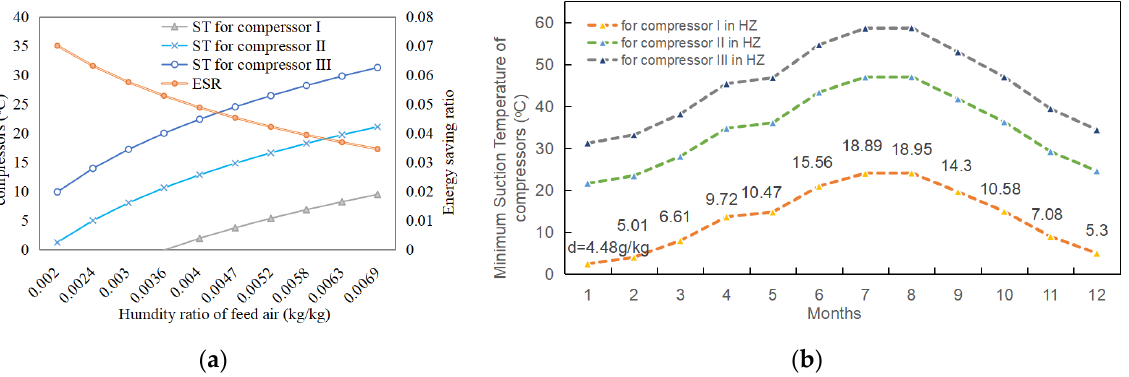
Figure 5. ( a ) Minimum suction temperature of each compressor under different feed air humidity; ( b ) Minimum suction temperature for each compressor in different months in Hangzhou.However, without external heat or electricity sources, the ST min cannot always be achieved. It is constrained by the cooling load allocation between SAHEXs ( Q sahexs ) and CWAHEXs ( Q cwahexs ). Q sahexs , which provides the generation heat of the OAR, and Q cwahexs , which is provided by the evaporation heat of the OAR, have to be distributed carefully to obtain enough generation heat while ensuring adequate cooling capacity for air cooling.